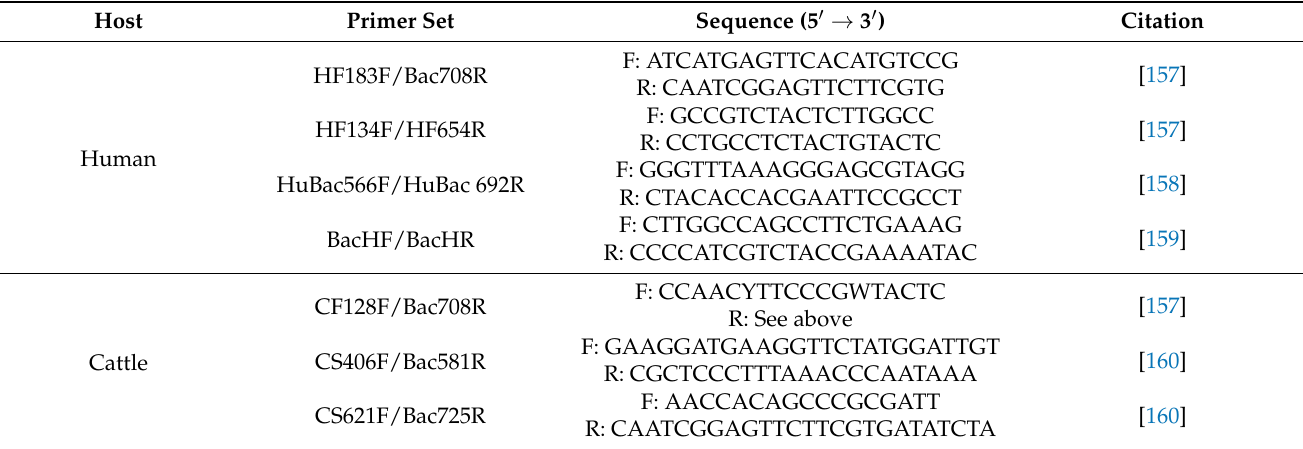
Table 2. Host-specific 16S rDNA fragments of Bacteroides spp. used to discriminate fecal pollution from human and animal